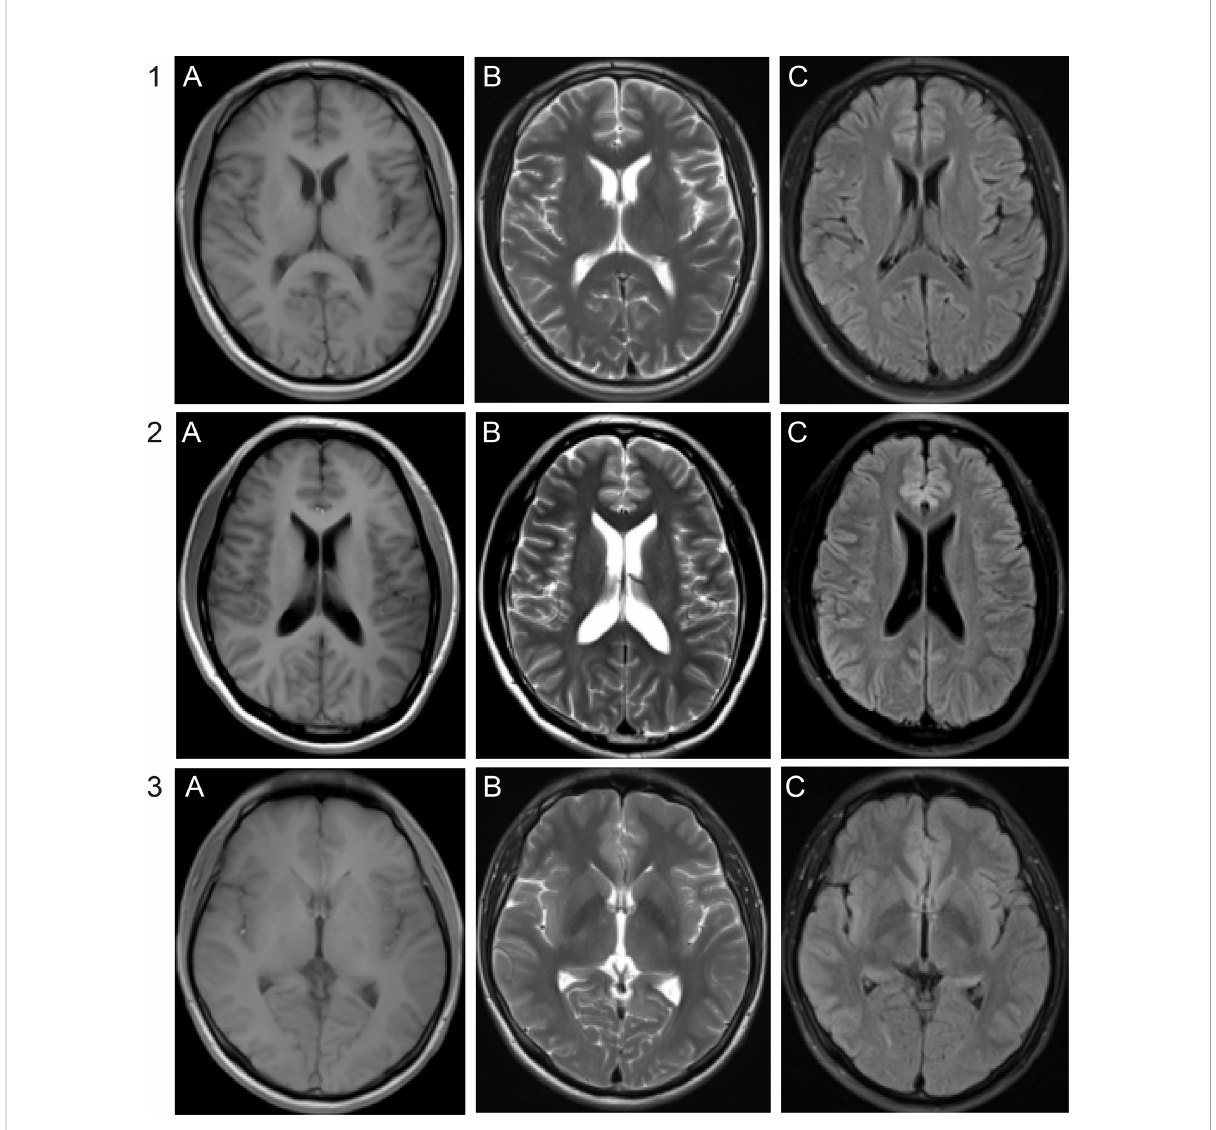
FIGURE 1 Brain MRI of the three patients. No abnormal signals were demonstrated on (A) T1WI, (B) T2WI, and (C) fl uid-attenuated inversion recovery (FLAIR) of patients 1, 2, and